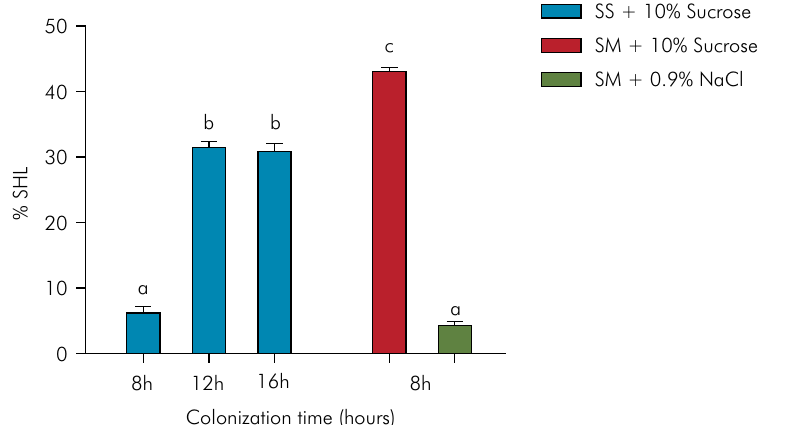
Figure 1. Acidogenicity of S. sanguinis biofilms at different times since initial dental enamel biofilm formation times.